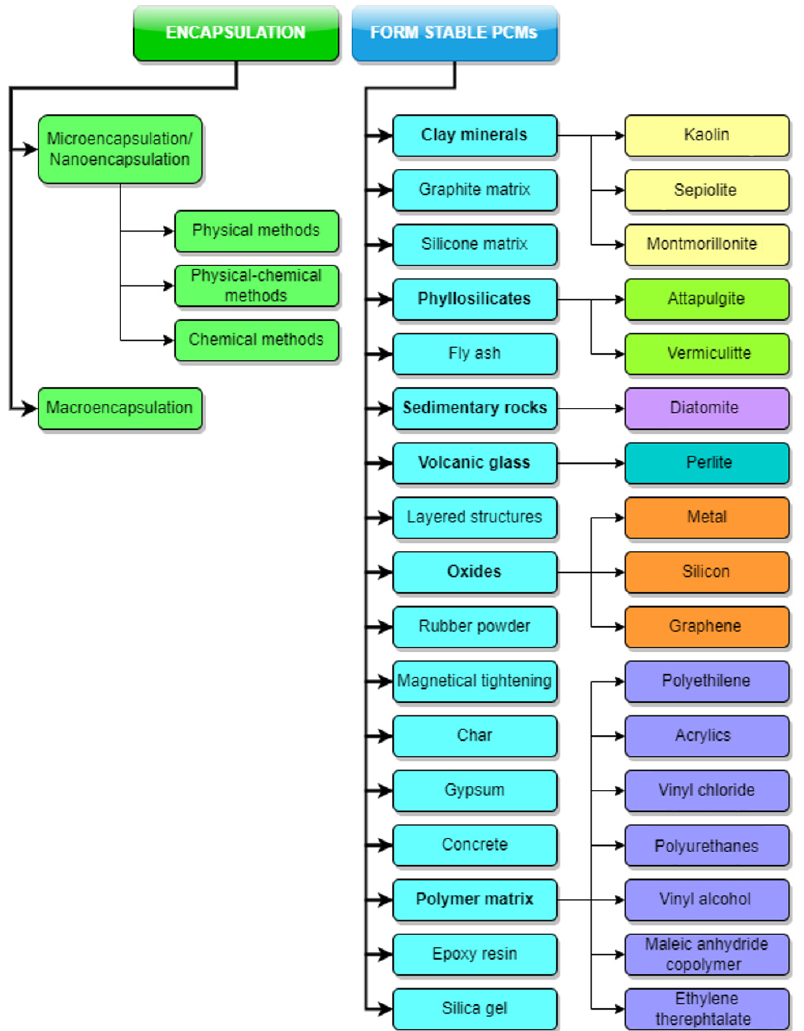
Figure 4. PCM containment methods. Kaolin [82,83]; Sepiolite [84]; Montmorillonite [85]; Attapulgite [86, 87]; Vermiculitte [88,89]; Diatomite [88,90,91]; Perlite [92,93]; Metal [94]; Silicon [95]; Graphene [96,97]; Polyethilene [98]; Acrylics [99,100]; Vinyl chloride [101,102]; Polyurethanes [103,104]; Vinly alcohol [105, 106]; Maleic anhydride copolymer [107–110]; Ethylene therephtalate